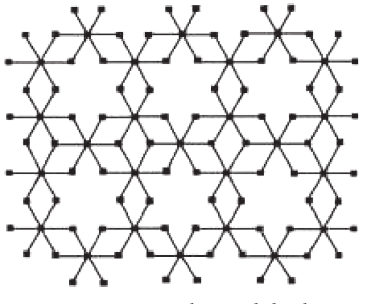
Figure 23: Bismuth triiodide sheet. Table 6: Degree-based edge partition of BiI